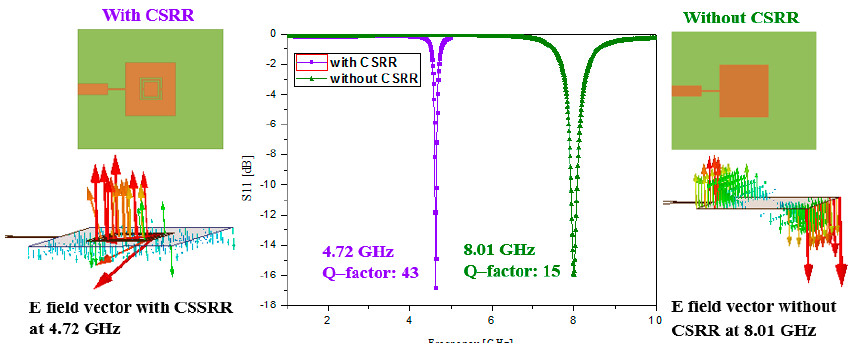
Figure 2. Comparison of resonant frequency and loaded Q-factor with and without CSRRs. E-field distributions with and without the CSRR are illustrated at 4.72 GHz and 8.01 GHz, respectively.